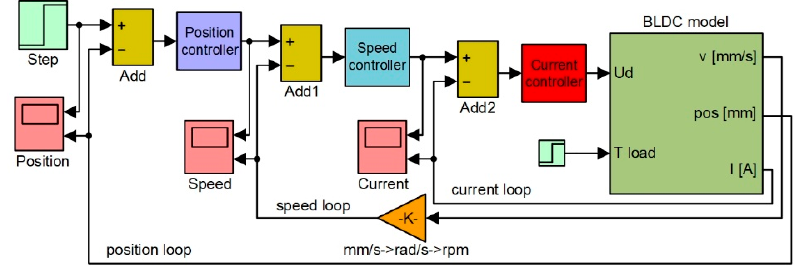
Figure 7. Control system of the morphing actuator based on three control loops. Figure 6. MATLAB/Simulink model of Brushless DC (BLDC) motor.